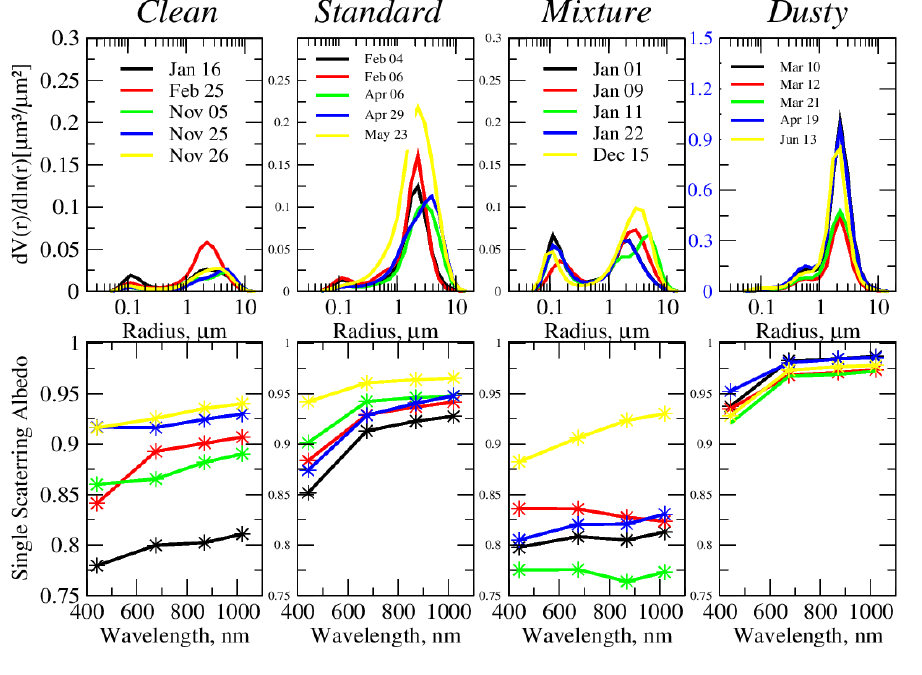
Figure 3. Same as Figure 2 for Niamey.